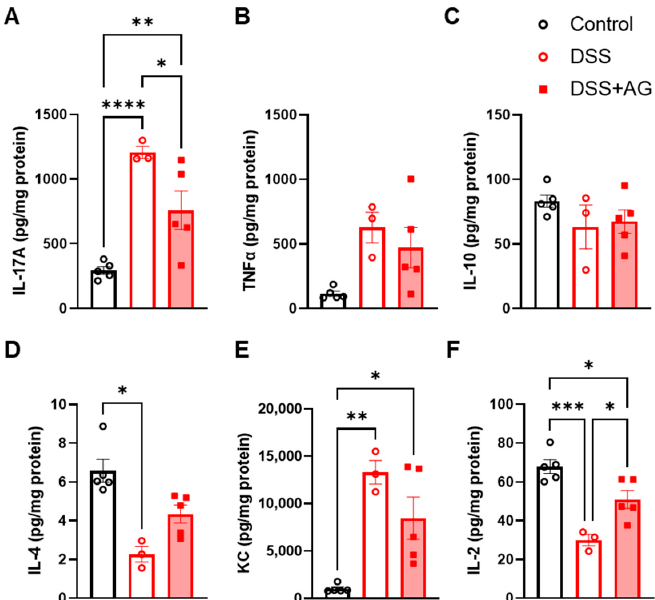
Figure 3. Ghrelin treatment alters inflammatory cytokines in old mice recovering from DSS-induced colitis. Colon samples collected on day 14 were processed and used for cytokine measurements: ( A ) IL-17A, ( B ) TNF α , ( C ) IL-10, ( D ) IL-4, ( E ) KC, ( F ) IL-2. Data were analyzed with one-way